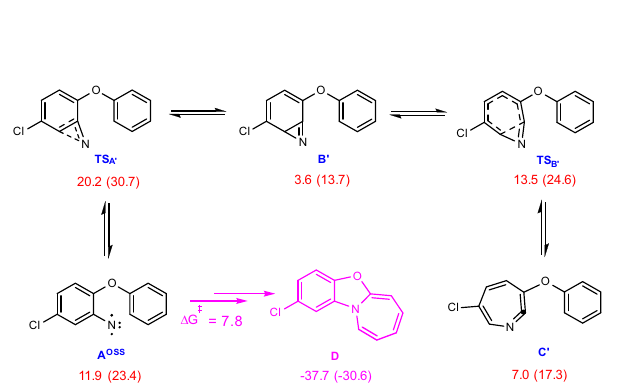
Fig. 9 | Calculated reaction mechanism for formation of normally produced B ʹ and C ʹ . Free energies (potential energies) calculated at the